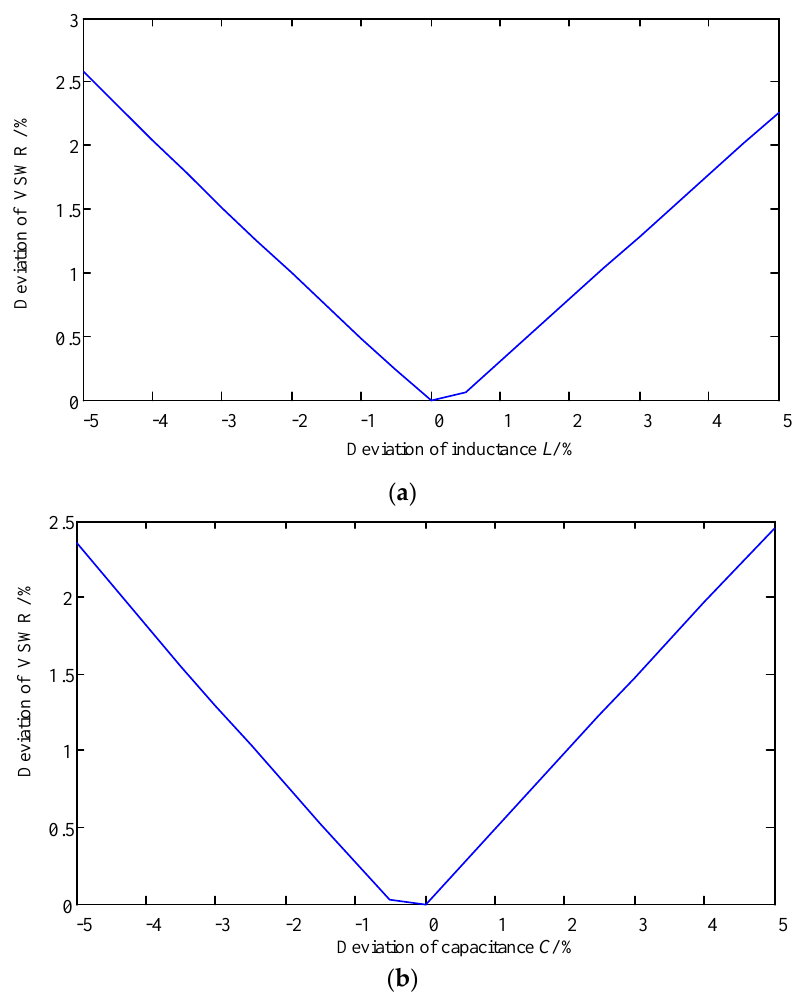
Figure 6. The effect of line parameters variation on VSWR. ( a ) Effect of inductance variation on VSWR; ( b ) Effect of capacitance variation on VSWR.